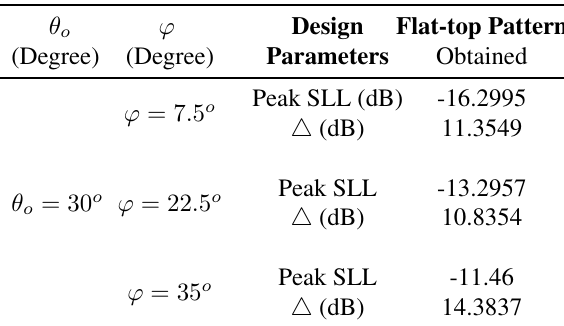
Figure 5: Optimized array after removing weekly excited elements (green represents “on” and red “off”)